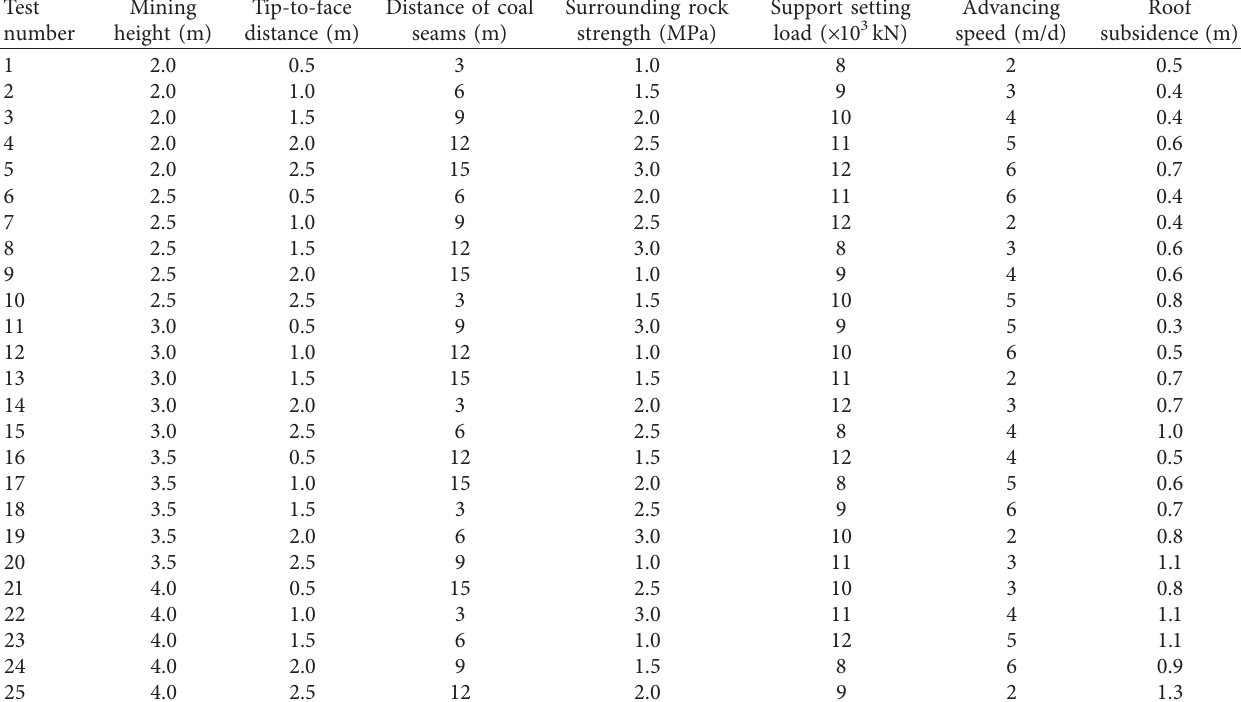
Figure 5: Face-end roof stability under different schemes. Table 7: Roof subsidence of the face end under different schemes.